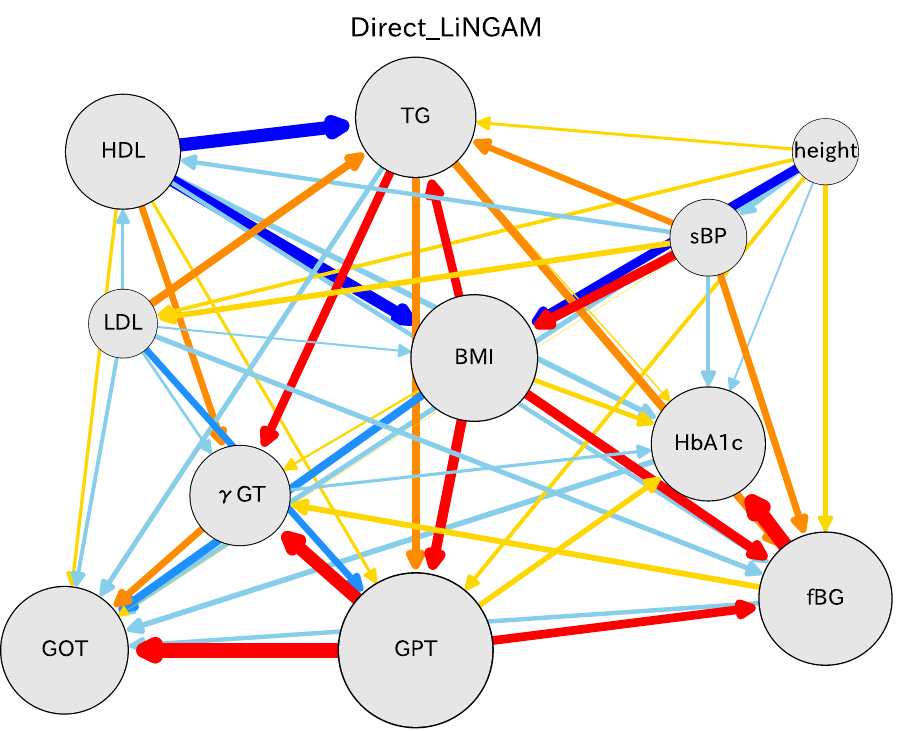
Fig 3. Causal diagram for women in their 70s. Arrows indicate the causal order between two connected indices. The arrow bar size is proportional to the logarithm of absolute value of the partial regression coefficient. The color depends on the partial regression coefficient b : red for b � 0.1, orange for 0.1 > b � 0.05, yellow for 0.05 > b > 0, sky blue for 0 > b � -0.05, blue for -0.05 > b � -0.1, and deep blue for b < -0.1.